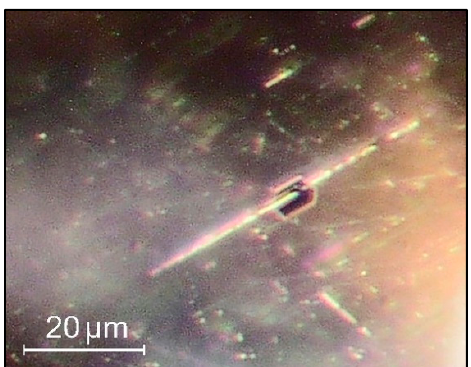
Figure 2. The characteristic inclusions in a CO 2 diamond—hexagonal platelets and needle-like inclusions. Photo: Dr. Thomas Hainschwang.